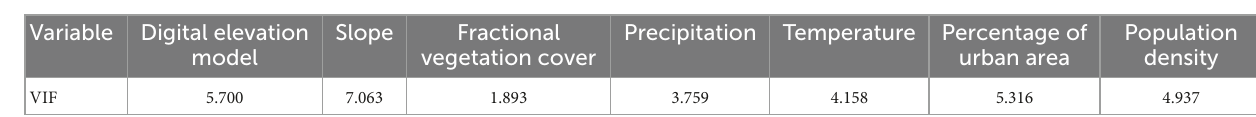
TABLE 2 Collinearity